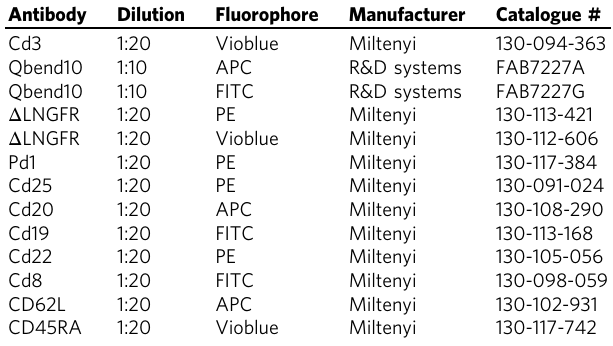
Table 1 Antibodies used in the